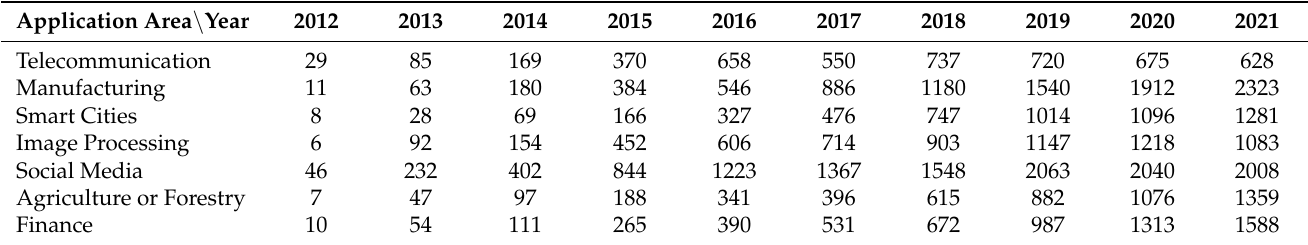
Table 2. The number of research publications per year for the seven application areas for Big Data that we have